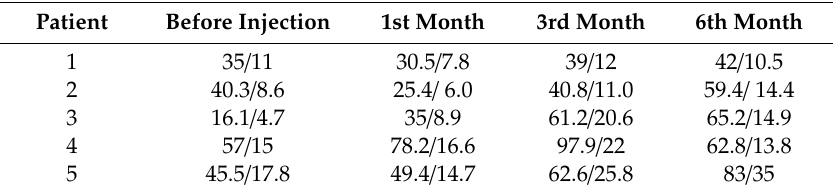
Table 4. Triplex results, presented as (PSV) / (EDV): Peak Systolic Velocity (PSV) / End Diastolic Velocity (EDV), measured at cm /